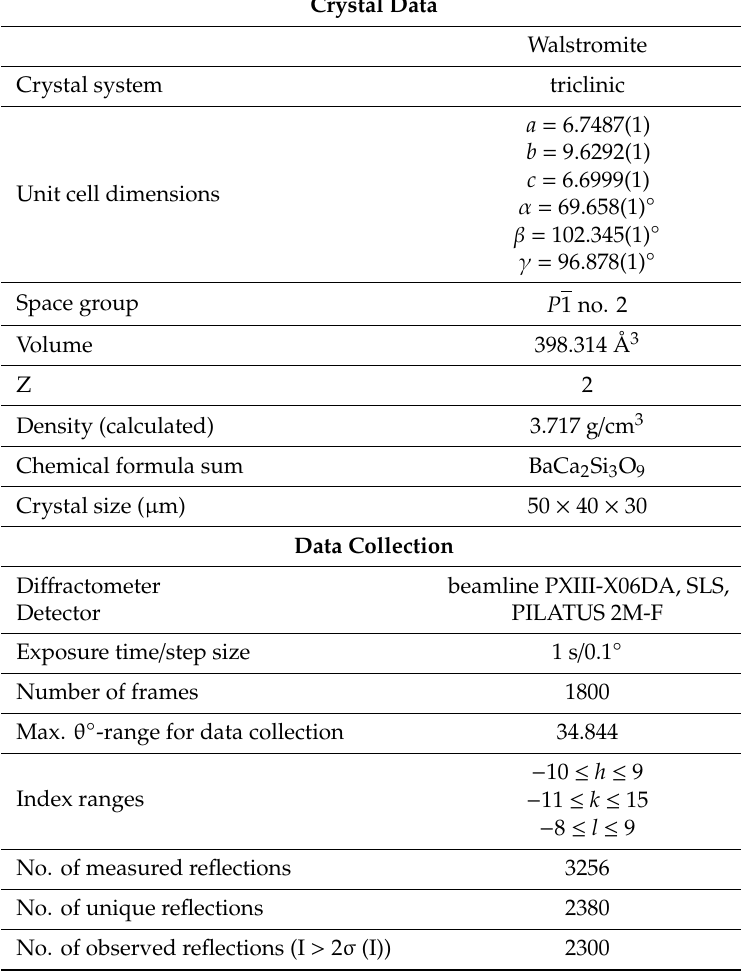
Table 1. Crystal data and structure refinement for